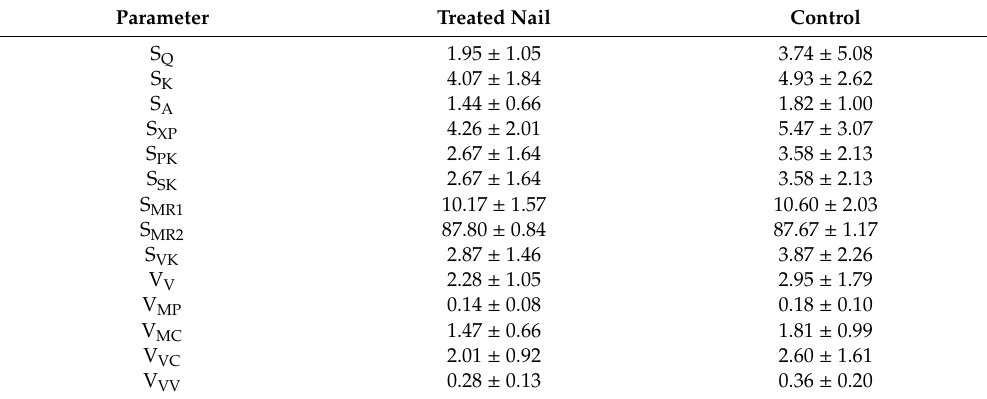
Table 2. 3D (S-parameters) and functional (volume) parameters according to ISO 25178 obtained to characterize the surface roughness of human nails (mean ± SD, n = 14).